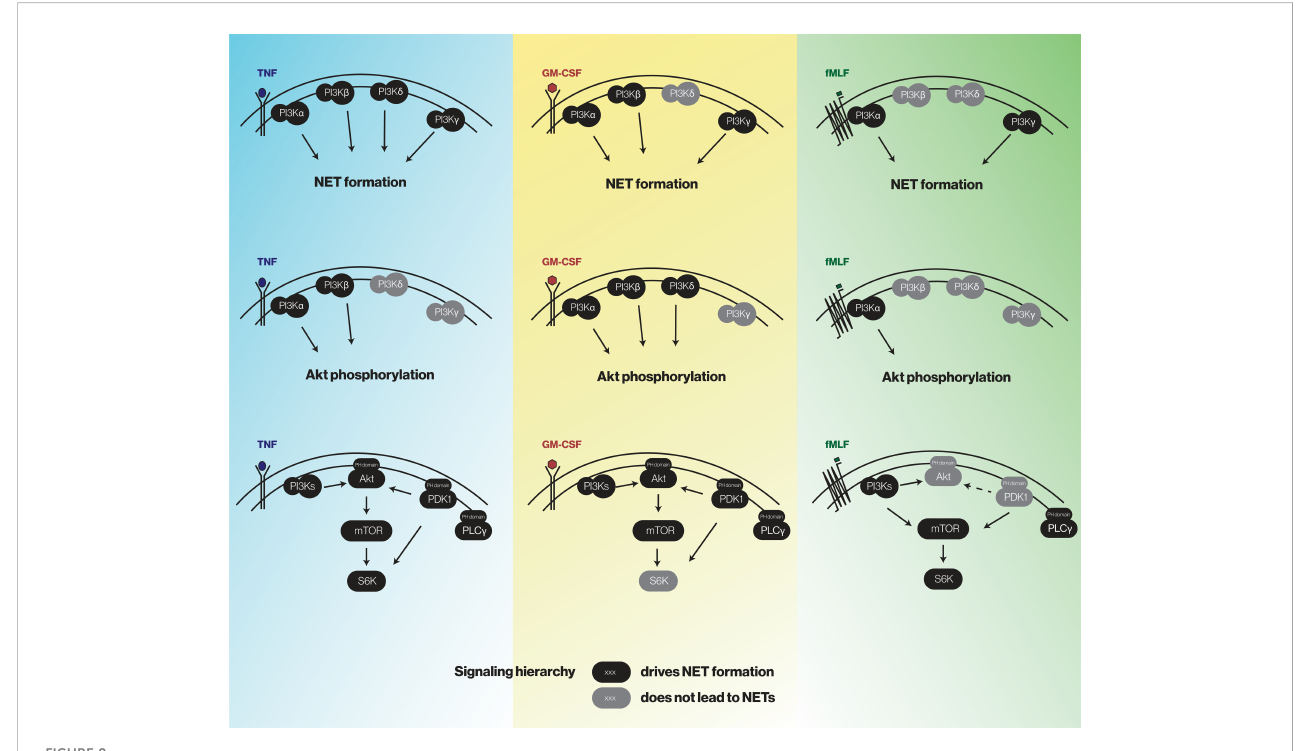
FIGURE 8 A summary of the fi ndings of this